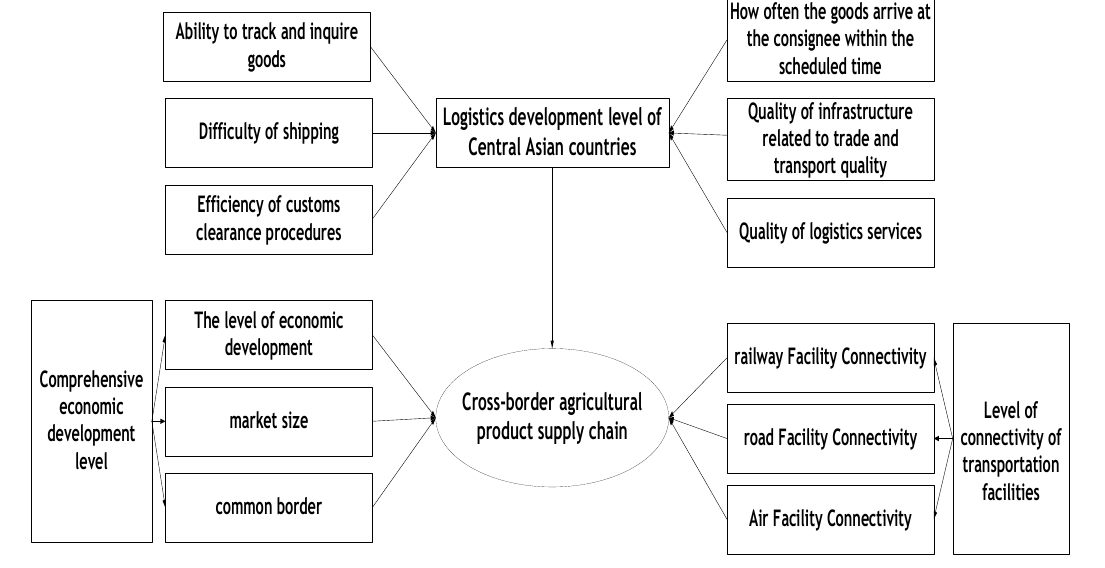
Figure 1. Influence